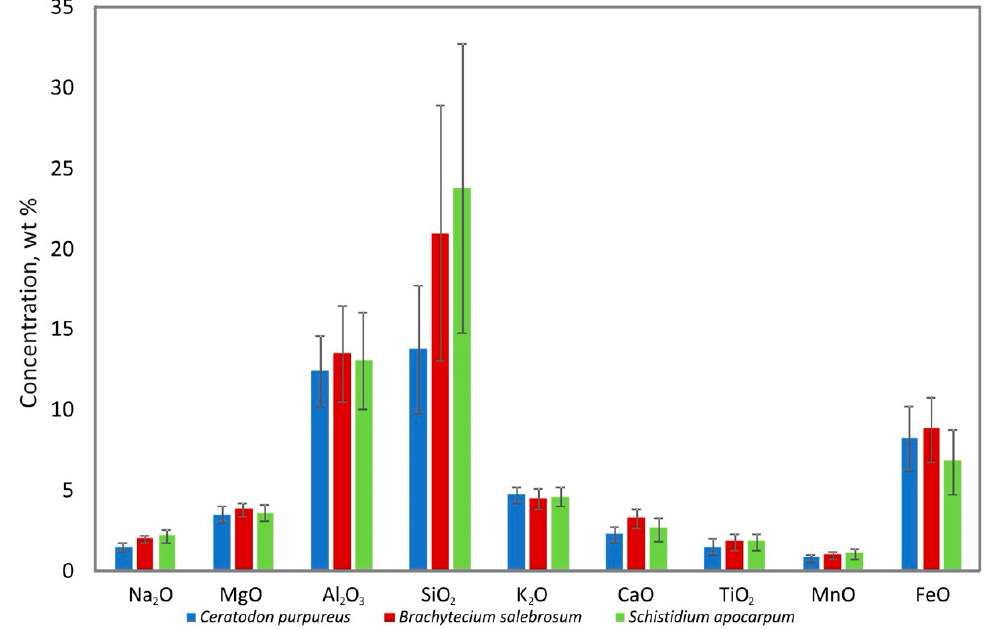
Figure 9. Content of the main impurity elements (wt%) in mosses of different species composition.